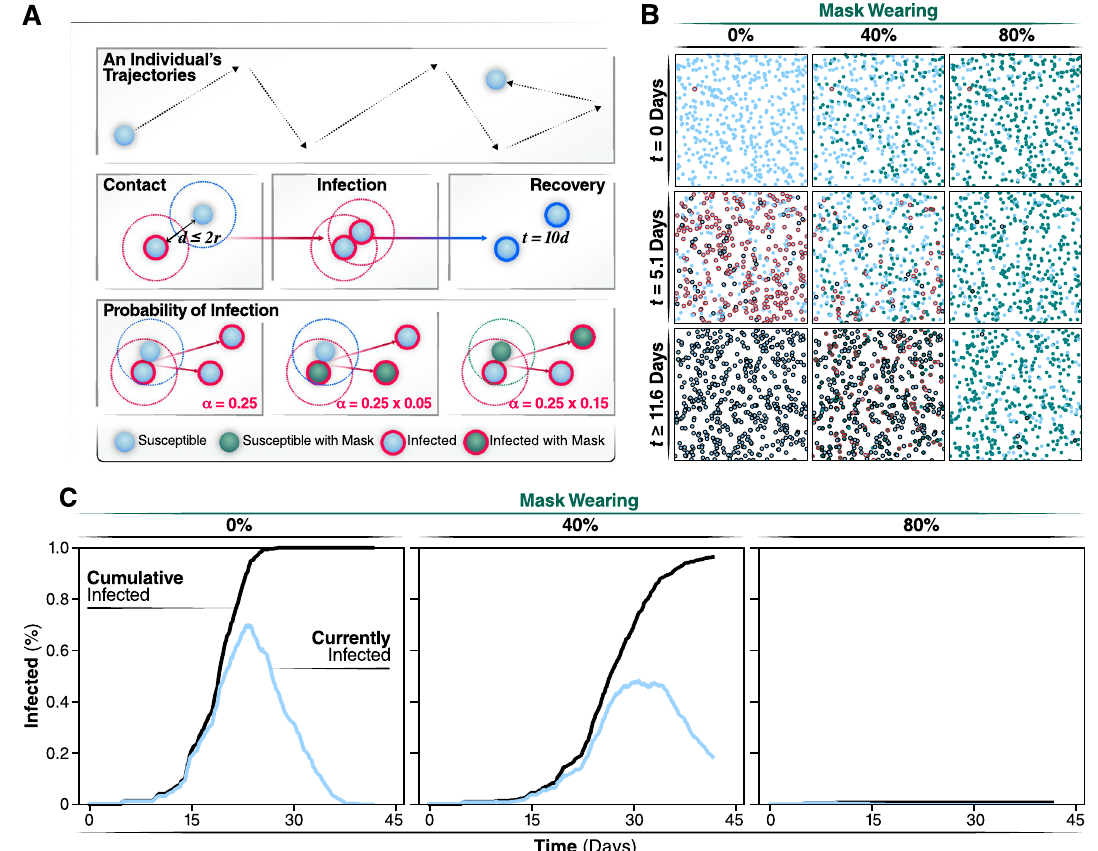
Figure 1. Individual states and rules of interactions. Using the same coloring system used in animated simulations, we show the different states an individual can be in during a simulation. Individuals keep the masked or not masked attribute assigned at initialization during the course of the simulation. ( A ) Spread of infection is caused by interactions of overlapping trajectories between infected and susceptible individuals. If the distance between individuals, d, is less than the radius of the two individuals, r, then an interaction occurs. Interactions initiate the generation of a random number that determines if transmission occurs. The chance of infection is randomly generated, based on a gamma distribution with shape parameter, alpha, of 0.25. This probability is further modulated by which individuals in the interactions are wearing face masks. ( B ) Agents are shown at their positions and states during snapshots of the simulation. Representative simulations of are shown of 0, 40, or 80% of the population wearing face masks. Snapshots are collected at days 0, 20, and 40 of the simulations. ( C ) Progression of the outbreak, the trajectory of the number of new daily infected individuals (Currently infected) and cumulatively infected from a representative simulation are graphed in light blue and black,